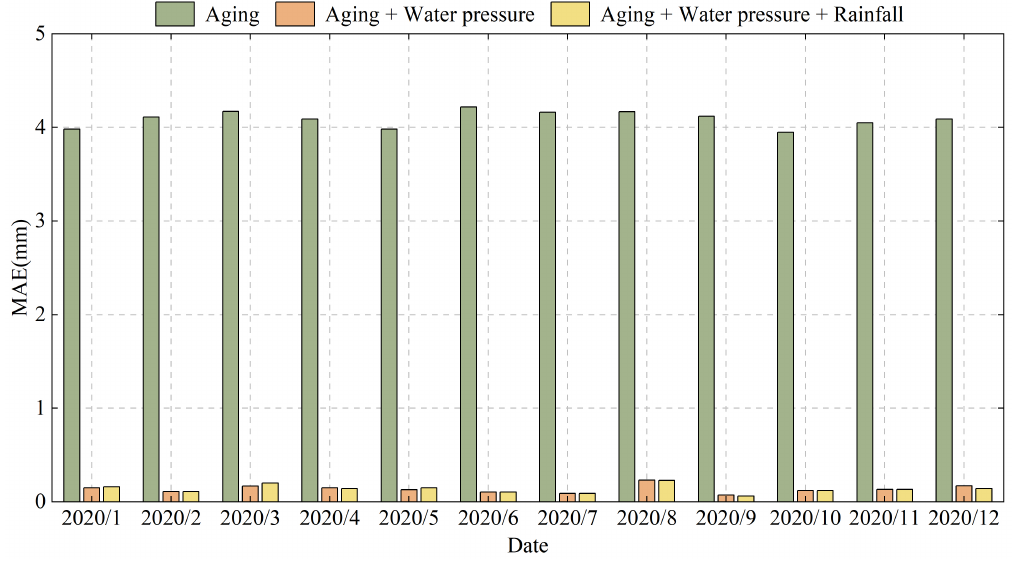
Figure 9. Comparison of MAE with selection of different covariates of the two–dimensional model. Based on the above, taking all environmental variables with the VIP j greater than 0.8